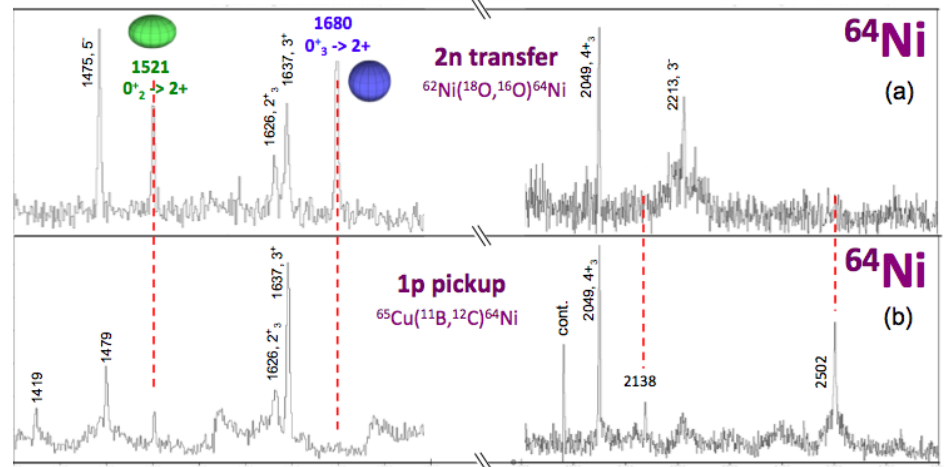
Figure 5. Portions of γ spectra of 64 Ni, as obtained from the two-neutron transfer reaction 62 Ni( 18 O, 16 O) 64 Ni (a) and the proton-pick-up reaction 65 Cu ( 11 B, 12 C ) 64 Ni (b) (both performed at beam energies ∼ 1 MeV below the Coulomb barrier energy), focusing on the transition energy region where the decay from the second and third excited 0 + states is expected. As in similar studies on 62 Ni (see Fig. 4), a clear difference in population pattern is generally observed. In the case of the proton pick-up reaction, a strong suppression in the population of both negative parity states and 0 + states is observed (see text for